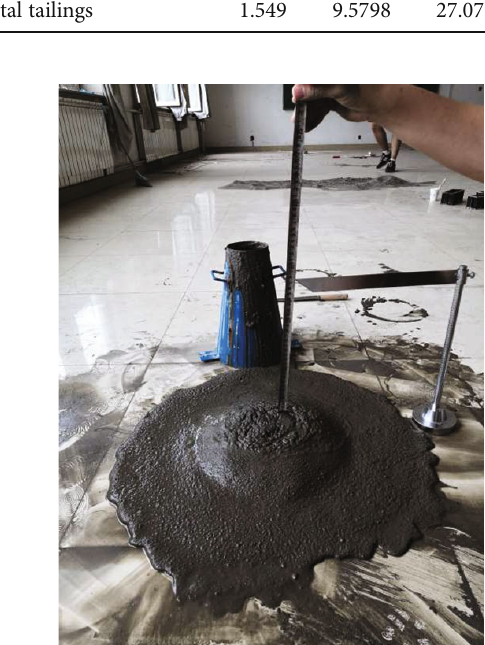
Table 3: Characteristic parameters of particle size distribution of total tailings. Characteristic parameter